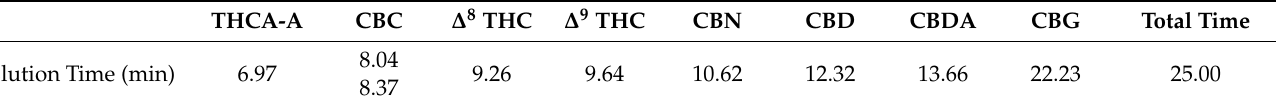
Table 4. Elution times for 10-cannabinoid normal-phase separation on Chiralpak IH-U.